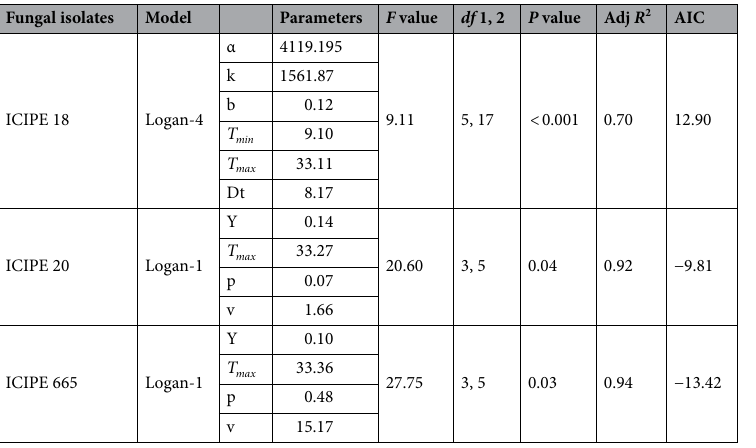
Table 3. Model parameters of Logan models describing the effect of temperature on virulence of fungal isolates against adult Tuta absoluta . F , F -test statistic; df , degree of freedom; P , probability value; R 2 , coefficient of determination; AIC, Akaike’s information